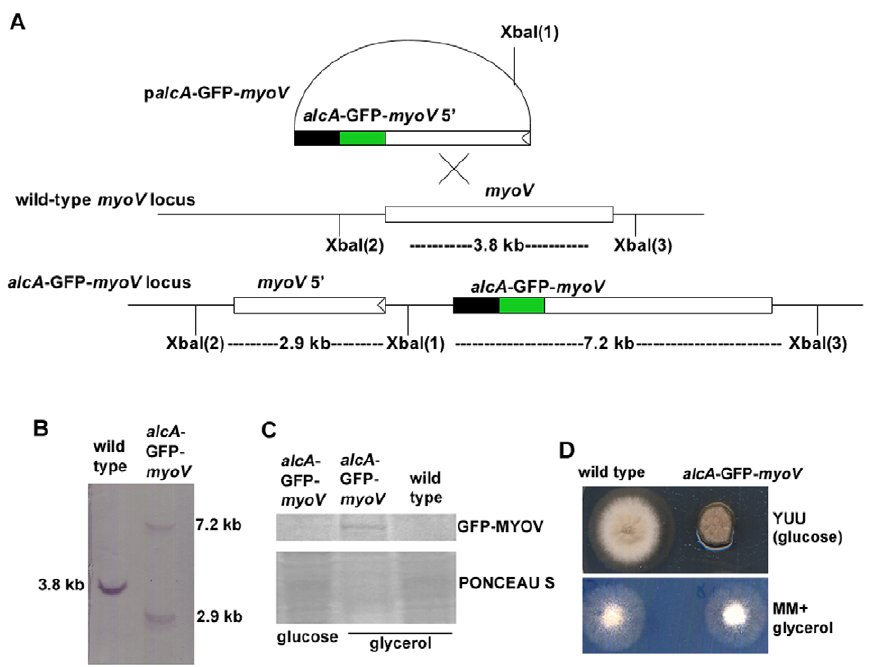
Figure 1. Construction of the alcA -GFP- myoV strain. (A) A diagram showing the homologous integration of the p alcA -GFP- myoV plasmid into the genome (see Materials and Methods for details). (B) A Southern blot confirming the homologous integration event. (C) A Western blot showing that the GFP-MYOV fusion protein can be detected in extracts of cells grown on glycerol but not on glucose. A protein extract from a wild type strain grown on glycerol was use as a negative control for the anti-GFP antibody. PONCEAU S staining of the same blot is shown as a loading control. (D) Growth phenotypes of the alcA -GFP- myoV strain grown on glucose (YUU) and glycerol (MM + glycerol) plates at 37 u C for 2 days. The strains were point inoculated on different plates. Note that on YUU, the growth of the mutant is significantly reduced, but on MM + glycerol, the mutant colony is almost